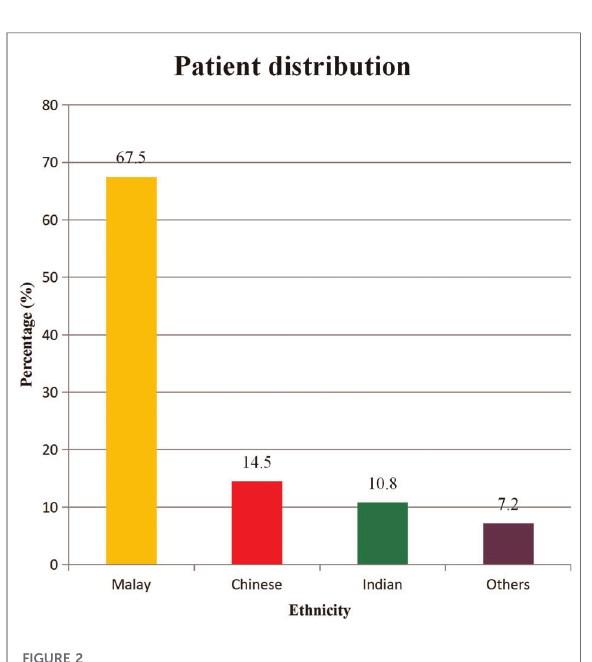
FIGURE 3 Percentage of patient (%) according to surgery